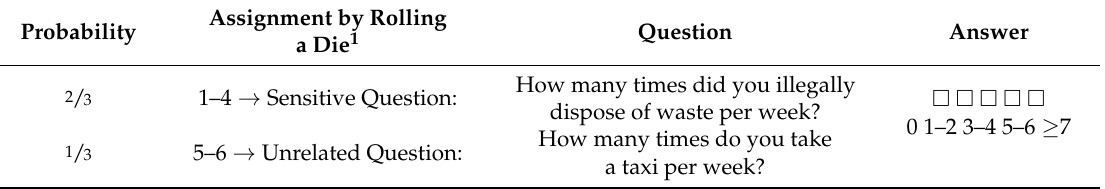
Table 2. Example of RRT application by using the unrelated question design